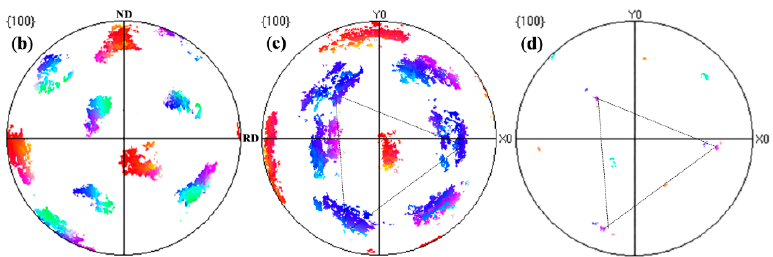
Figure 3. ( a ) Band contrast images of 2# specimen; two pole figures ( b , c ) corresponding to the prior austenite grain γ -A and γ -B in image ( a ); pole figures ( d ) corresponding to the selected sections of ‘b’ in image ( a ).